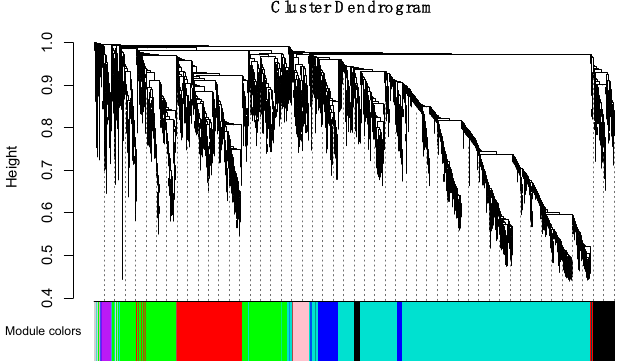
Figure 5. Hierarchical clustering dendrogram of channel catfish, Ictalurus punctatus , genes with dissimilarity based on topological overlap during early development. Each single leaf in the tree represents a single gene, the major tree branches constitute 12 distinct modules and are shown in different colors.